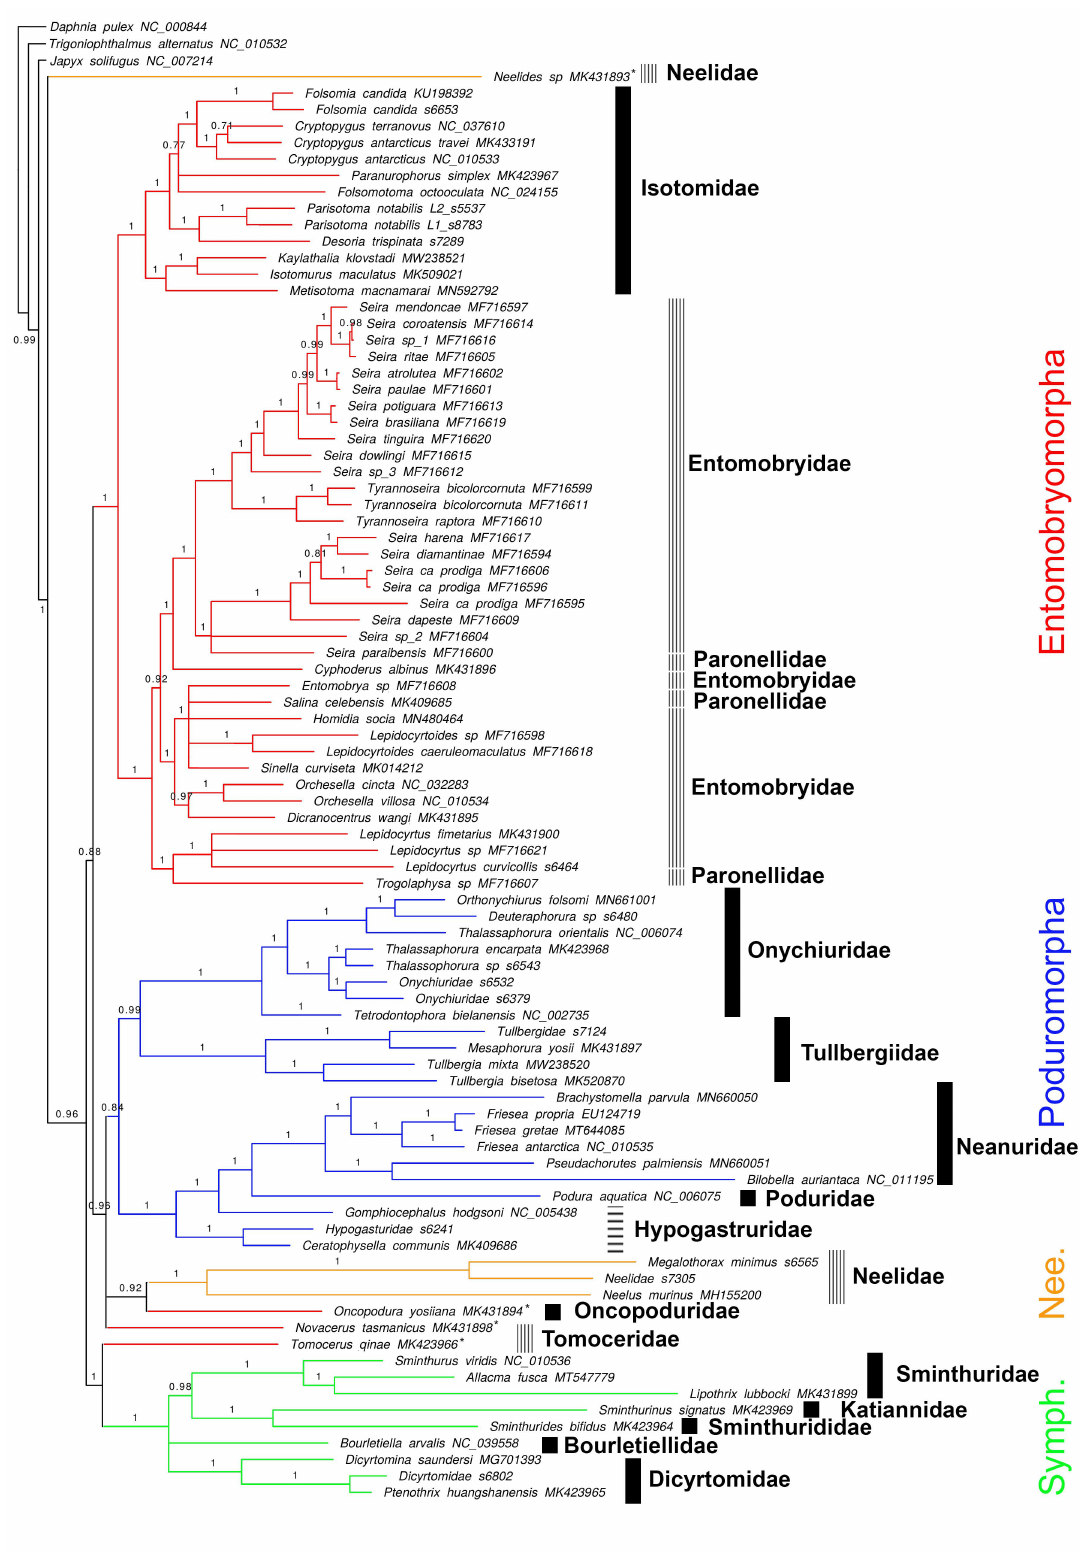
Figure 4. Bayesian phylogenetic reconstruction based on first and second codon positions. Numbers at nodes indicate posterior probabilities. Monophyletic, paraphyletic, and polyphyletic families are defined with filled, horizontal and vertical rods. Outliers species are highlighted with asterisks. Nodes with support < 0.70 were collapsed. Outgroup nodes not to